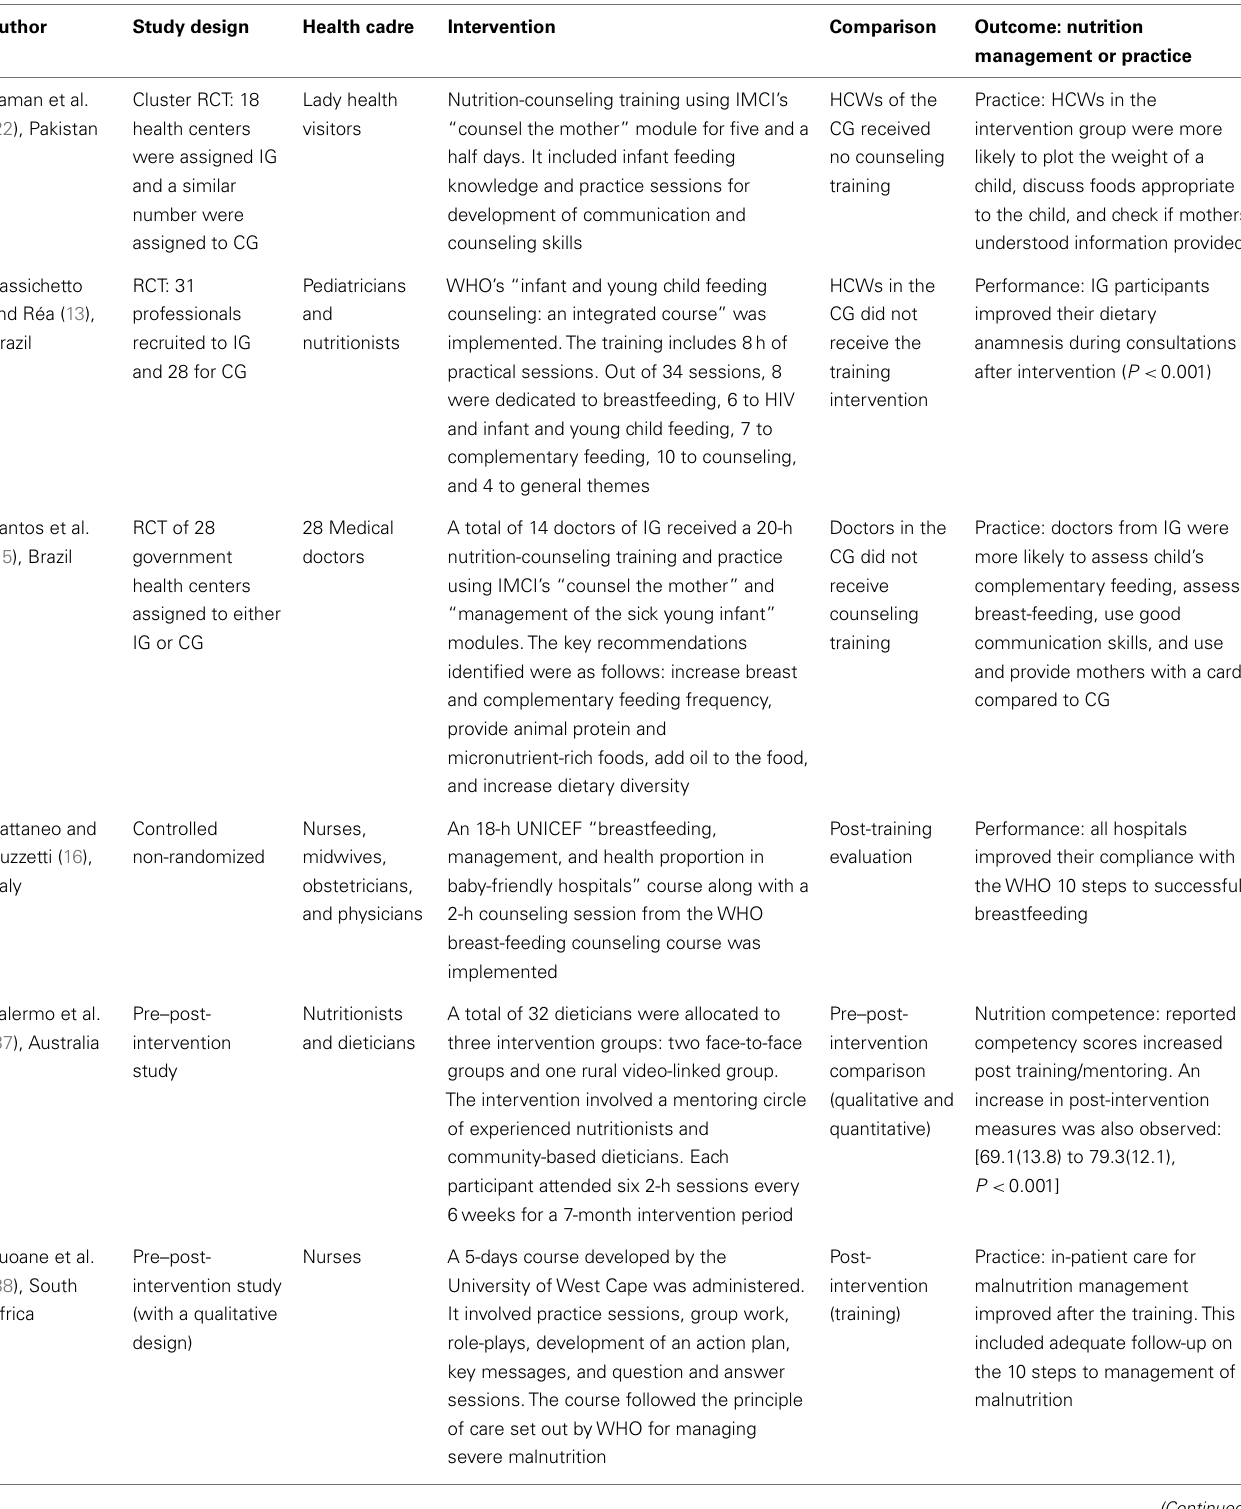
Table 7 | Effectiveness of nutrition training to improve nutrition management practices and competence of health